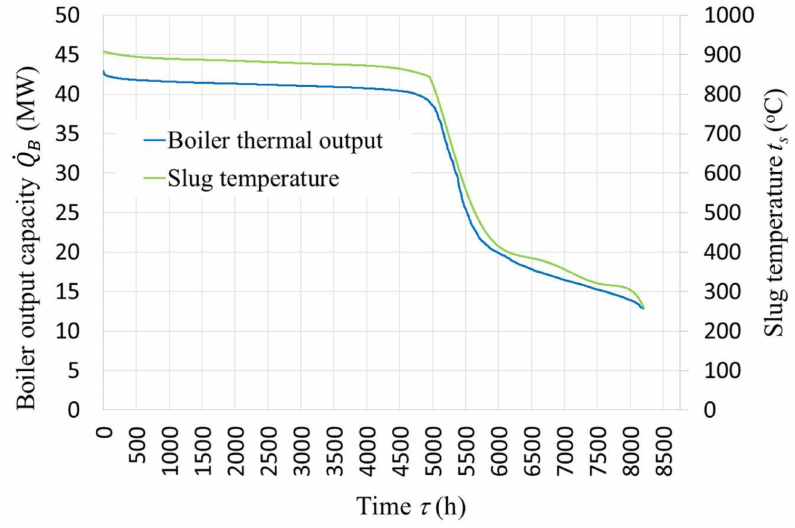
. Q B and slag temperature t s at the end